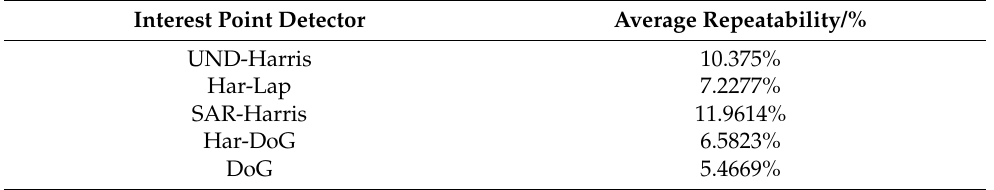
Table 2. Average repeatability of five